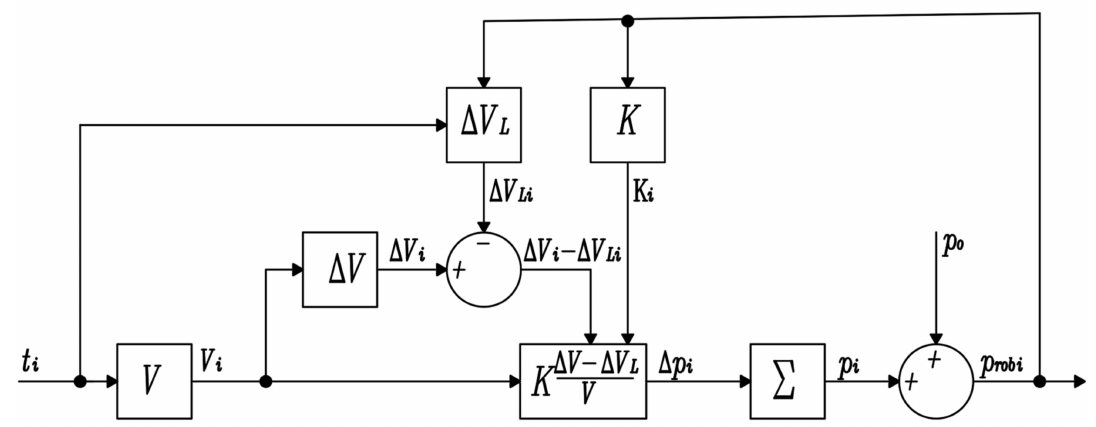
Figure 23. Simplified block diagram of the discrete simulation model of the compression process.